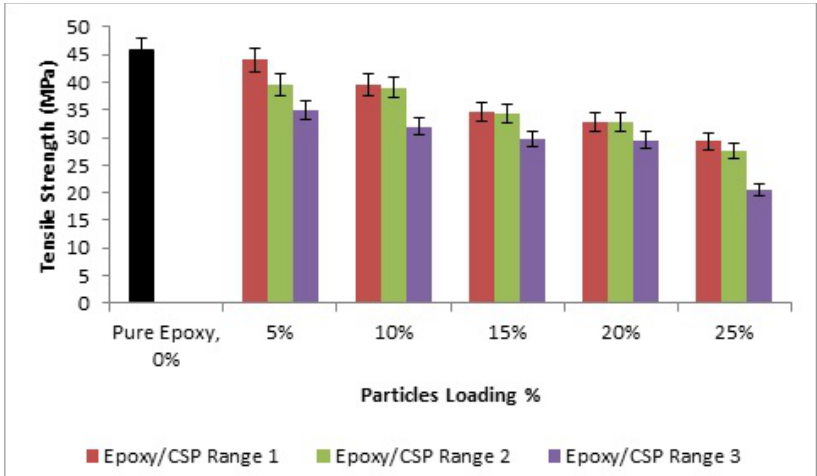
Figure 2: Tensile strength versus various particles loading